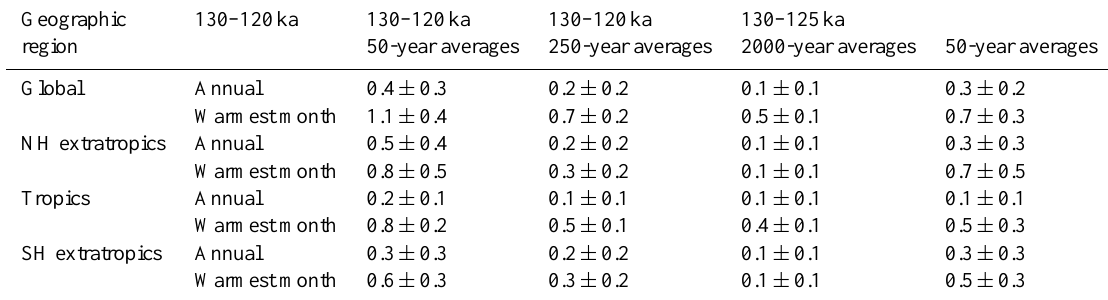
Table 3. Robustness of MMM overestimation of LIG maximum warmth. Calculated MMM overestimation of LIG maximum warmth (mean ± 1 σ ; ◦ C) and the dependence of the results on the two main choices: time frame of the LIG period over which the calculations are performed (130–120ka in columns 3, 4 and 5; 130–125ka in column 6) and the temporal resolution of the simulated temperature time series (50-year averages in columns 3 and 6; 250-year averages in column 4; 2000-year averages in column 5). Values are given for annual mean temperatures and for temperatures of the warmest month as well as for four different geographical regions: global, NH extratropics (30–90 ◦ N), tropics (30 ◦ S–30 ◦ N) and SH extratropical (90–30 ◦